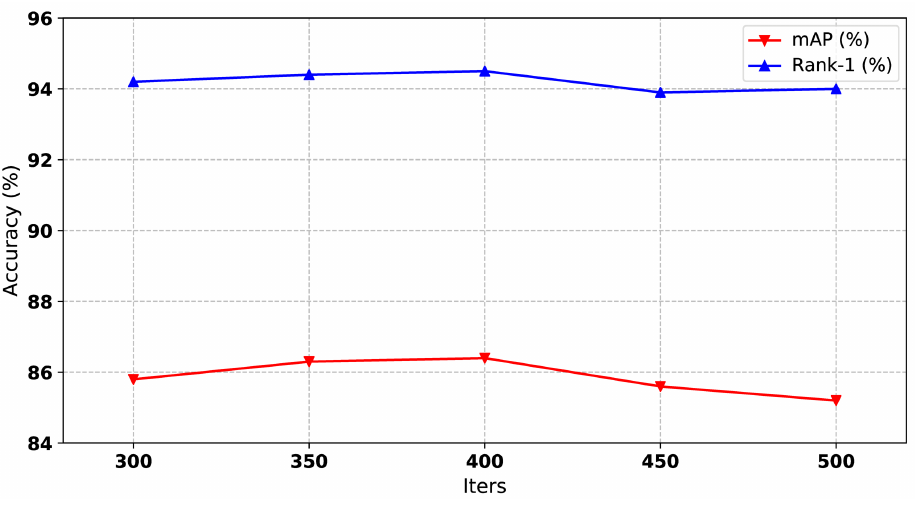
Figure 4. The impact of training iterations of our method on Market1501 dataset. Both mAP and Rank-1 are used to evaluate the performance. The x-axis represents the number of training